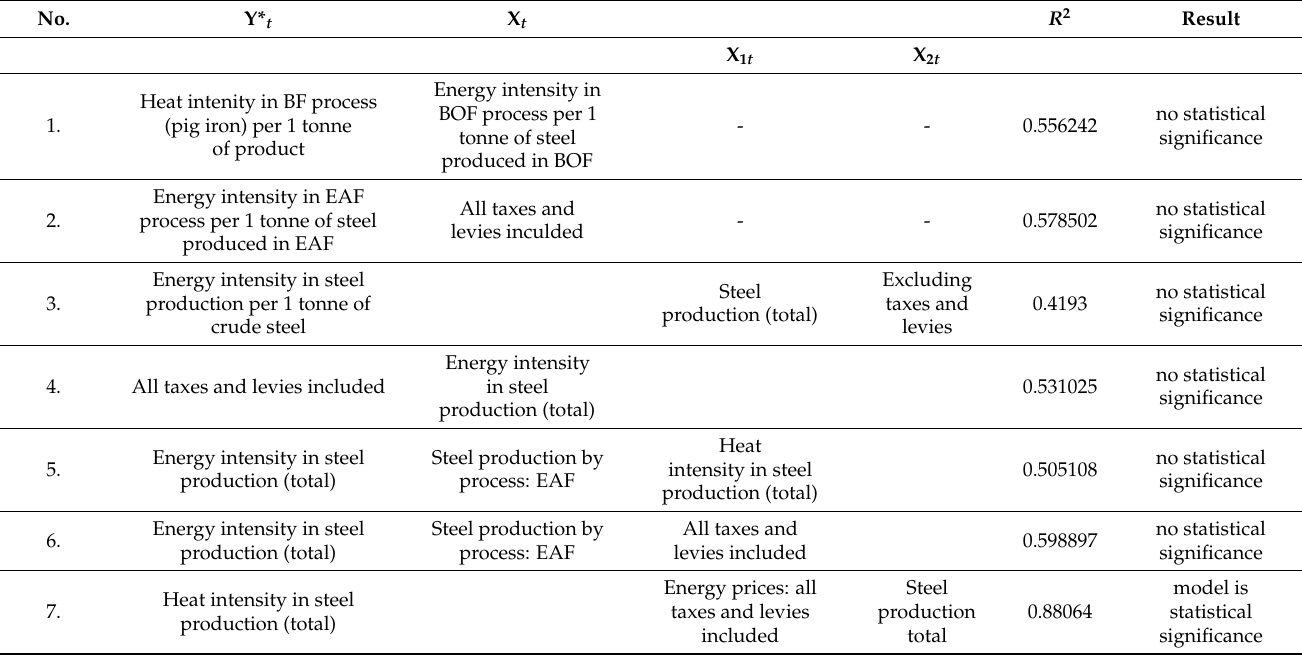
Table 3. Tested one- and two-parametric econometric models with linear function in the period T: from 2004 to 2020, t -year, ( n = 17).